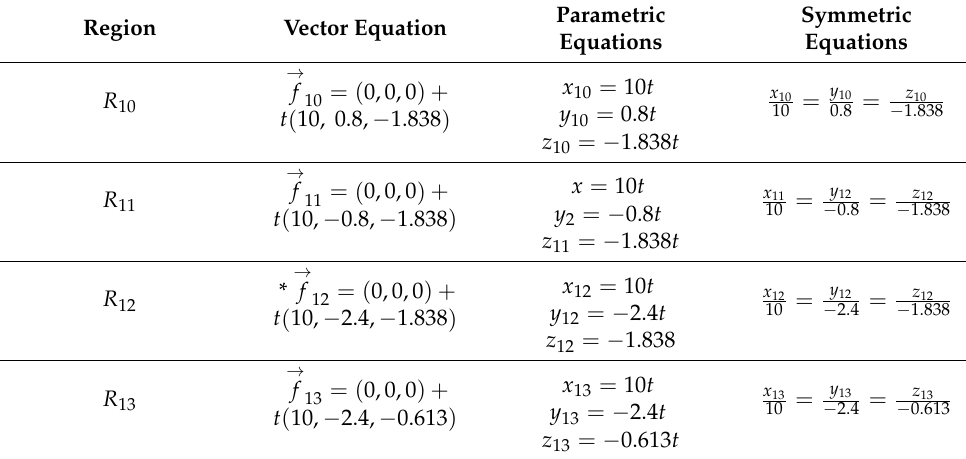
Figure 11. Results obtained by the third experiment when the vector 𝒇⃗ 𝟏𝟐 is used as a reference: ( a ) motion control; ( b ) attitude control; ( c ) control inputs; ( d ) 3D simulation.